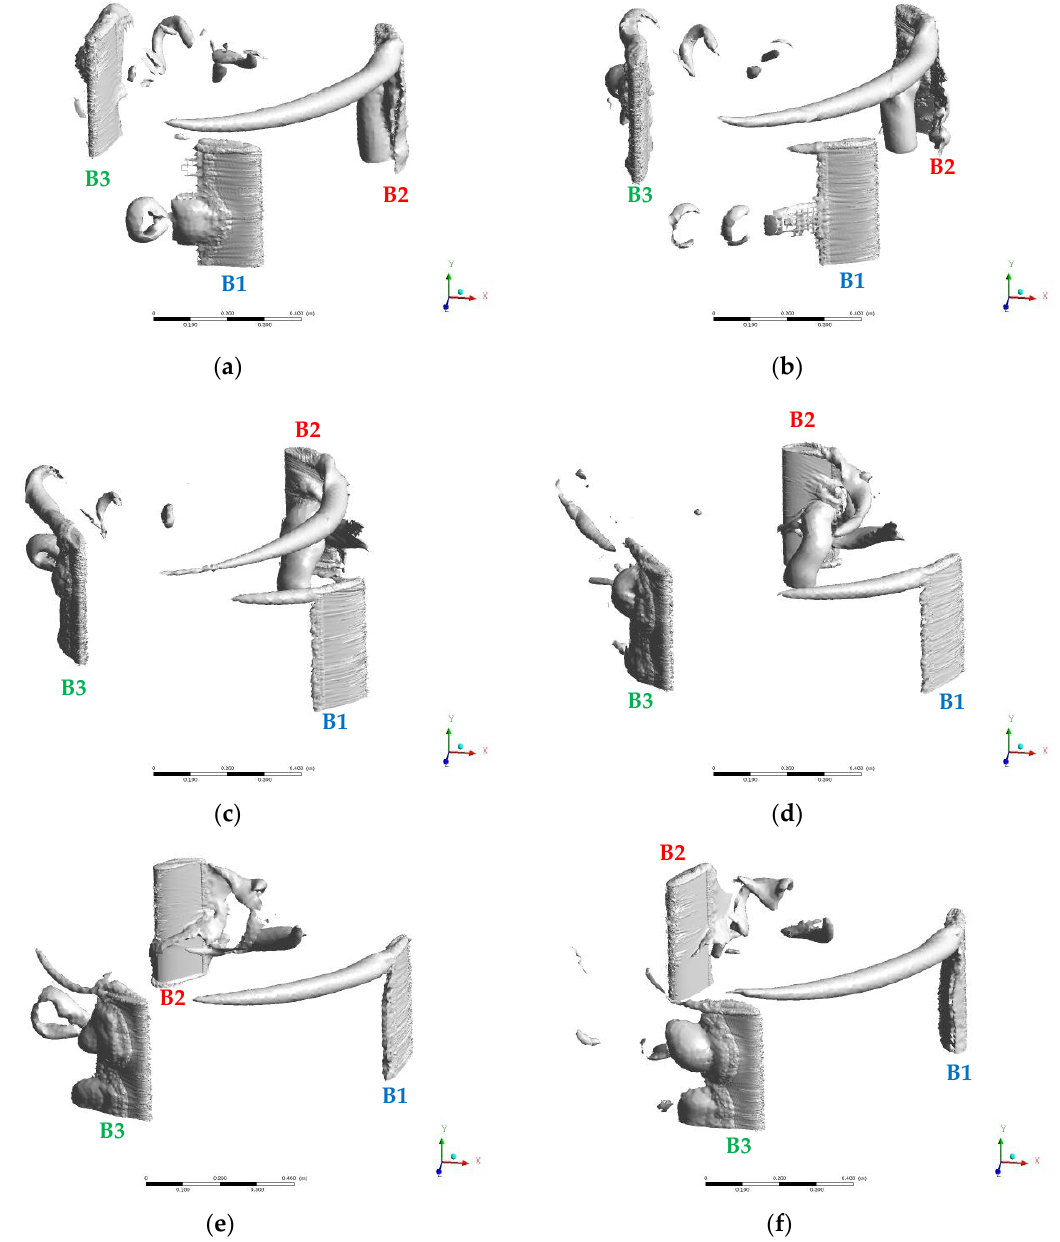
Figure 11. 3D visualization of the evolution of the vorticity iso-surface of 60 Hz for Ω = 50 rpm. Azimuth angle change at each view from ( a – f ) corresponds to 20 o , approximately.